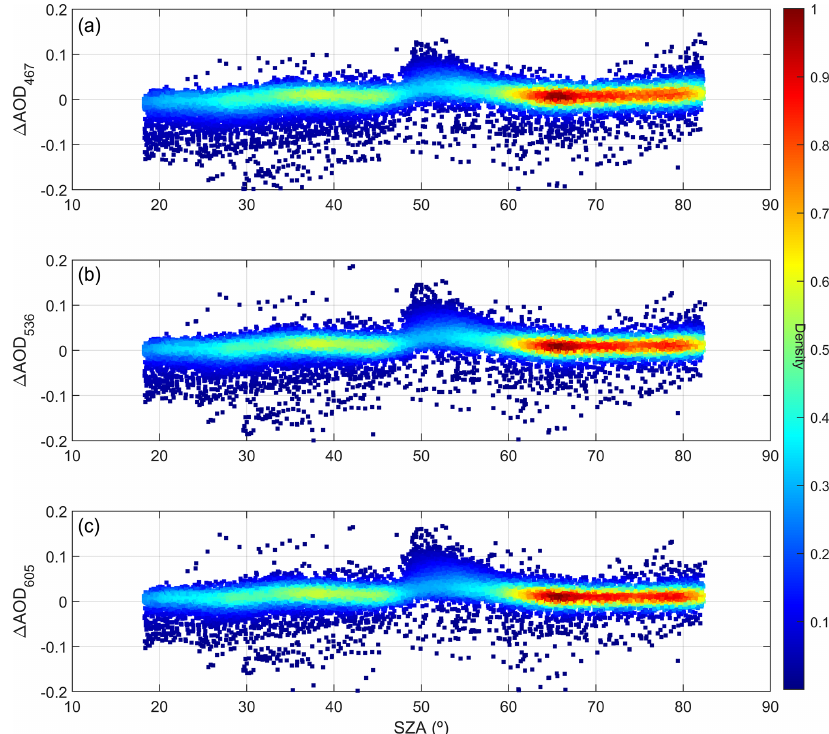
Figure 16. The (cid:49) differences in the aerosol optical depth (AOD) retrieved by GRASP with the multi-pixel approach (GRASPmp-CAM) and those obtained by AERONET at 467nm (a) , 536nm (b) and 605nm (c) as a function of the solar zenith angle (SZA). The colour legend represents the density of the plotted data